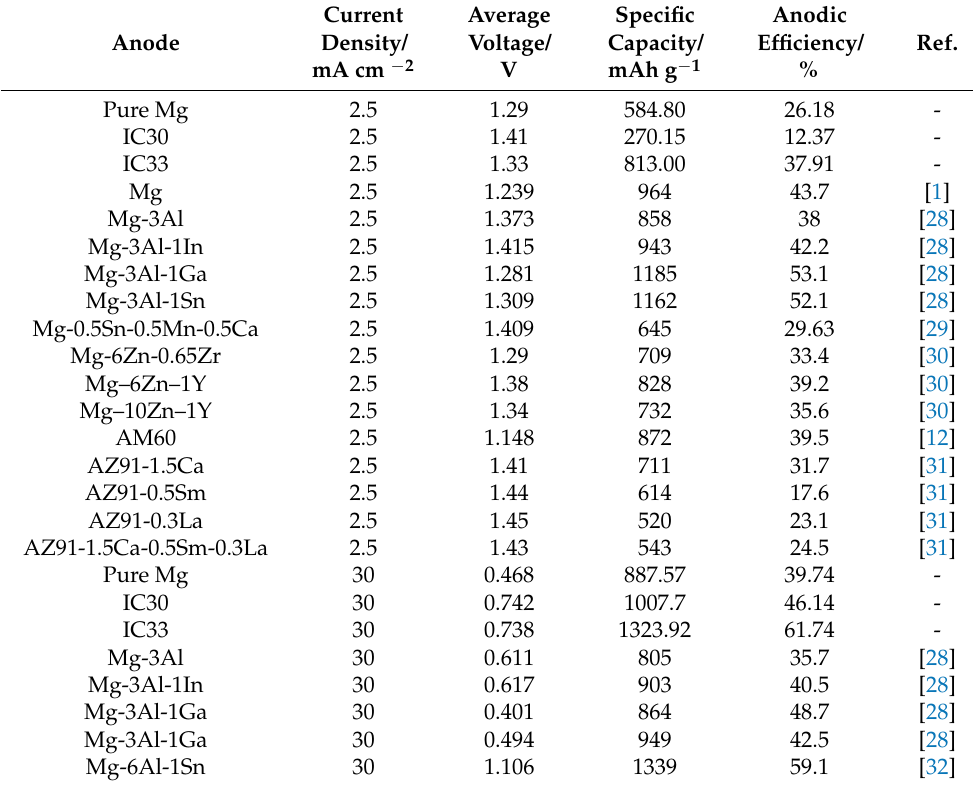
Table 5. Electrochemical and battery properties of different